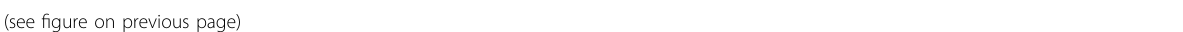
Fig. 5 Expression of RPS7 is positively correlated with the expression of SMYD2 and LUAD tumorigenesis. A Knockdown ef fi ciency of SMYD2 in GLC-82 cells was con fi rmed through western blotting, with GAPDH as an internal control. B The heat map showed that the knockdown of SMYD2 affected 111 genes expression, including 24 upregulated and 87 downregulated genes. The samples were from three independent transfections with three different siRNA sequences. C The mRNA expression of the indicated genes in control or SMYD2 knockdown GLC-82 cells. The error bars represent the mean ± SD of three independent experiments. **** p < 0.0001 (two-tailed unpaired T test). D ChIP-qPCR assays indicated that loss of SMYD2 diminished the enrichment on the promoter of the RPS7 gene. * p < 0.05 (two-tailed unpaired T test). E There was a positive correlation between the expression of SMYD2 and RPS7 mRNA expression by RT-qPCR using 18 lung adenocarcinoma tissue samples ( r = 0.552, p = 0.017, Spearman ’ s correlation analysis). F The protein expression of SMYD2 was positively correlated with RPS7 by IHC analysis ( r = 0.261, p = 0.002, Spearman ’ s correlation analysis). G The patients with low expression of RPS7 showed higher DFS ( p = 0.011) and OS ( p = 0.194) compared to those with high expression. H The patients with SMYD2high/RPS7high had worse survival outcome, compared with SMYD2low/RPS7low patients from our hospital ( p =